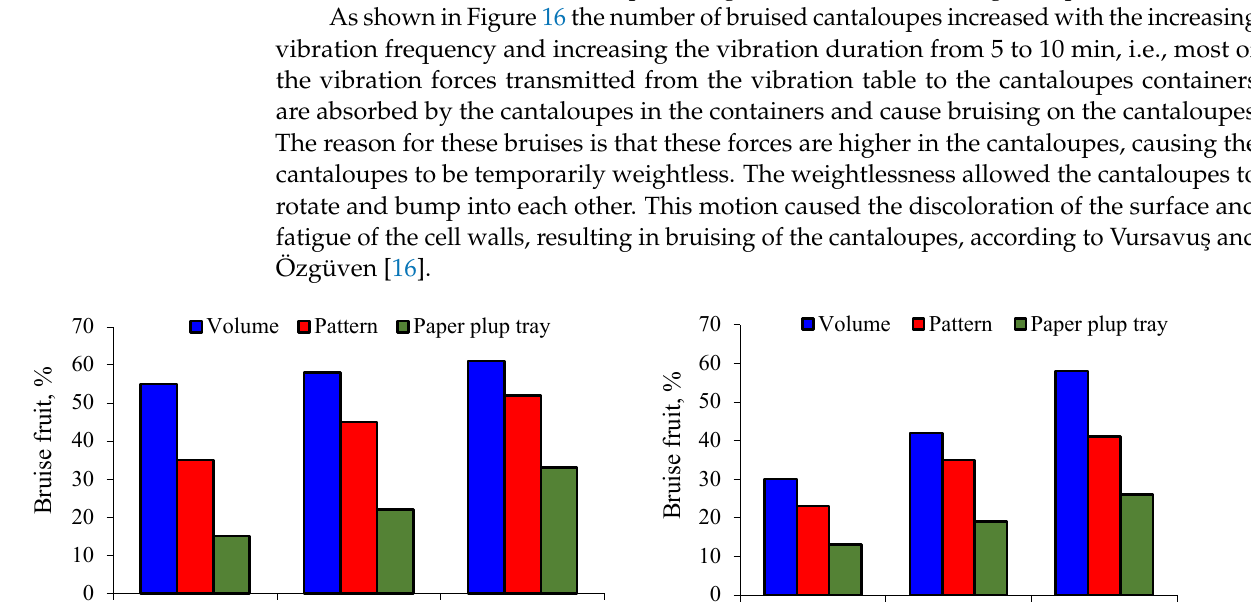
Table 4. Determining the natural frequency, damping ratio, elasticity, and stiffness factor for canta- loupe fruit for the paper pulp tray packing method.